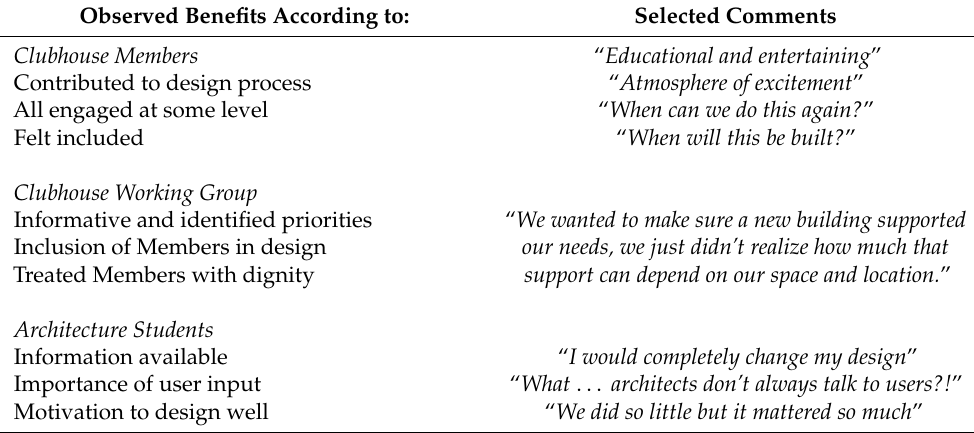
Table 2. Potential benefits of participatory exercises for the Members, Group, and